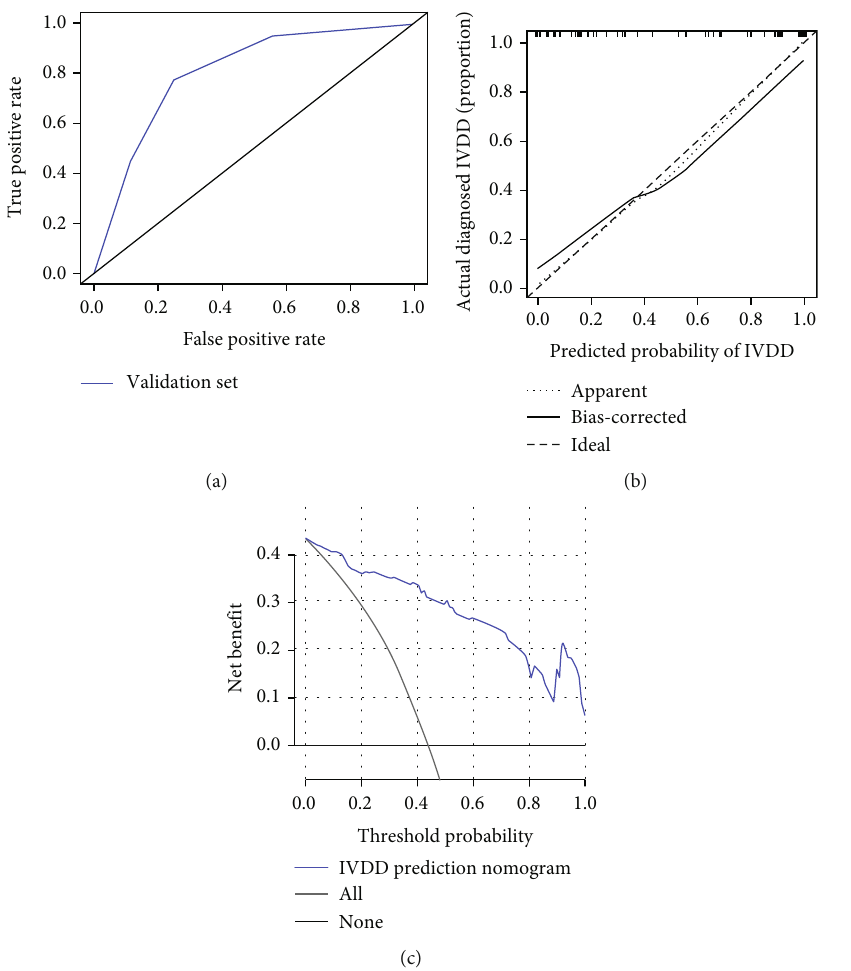
Figure 5: The ROC curve, calibration curve, and DCA curve of the validation group. (a) The ROC curve of the validation group. (b) The calibration curve of the validation group. (c) The decision curve of the validation